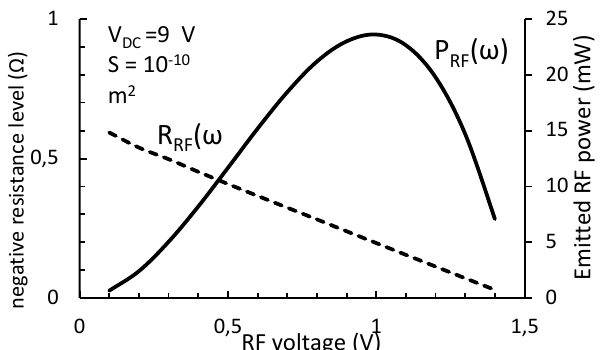
Figure 12: Intrinsic RF emitted power and negative resistance level in an elementary slice of the DTED as a function of the RF voltage.